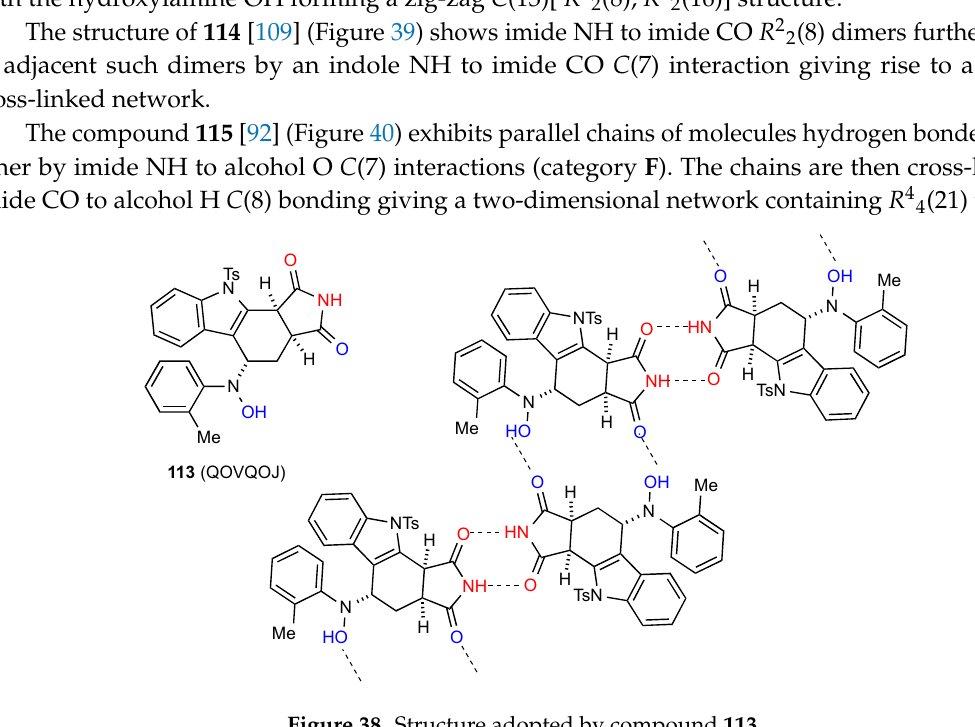
Figure 37. Six-membered ring-fused succinimides showing patterns H and D.